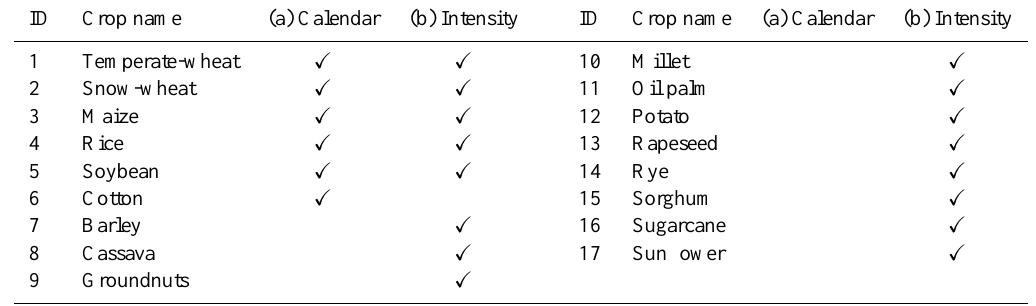
Table 2. List of crops. Checkmarks denote crops used for (a) estimation of crop calendar and (b) comparison of cropping intensity.